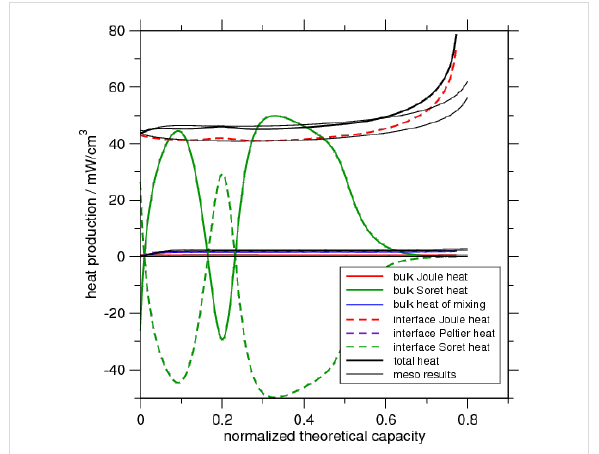
Figure 6: Heat production for ellipsoid-based micro-structure due to different heat sources. Thick lines show the results from the micro- simulation while the thin black lines are the results of the corres- ponding